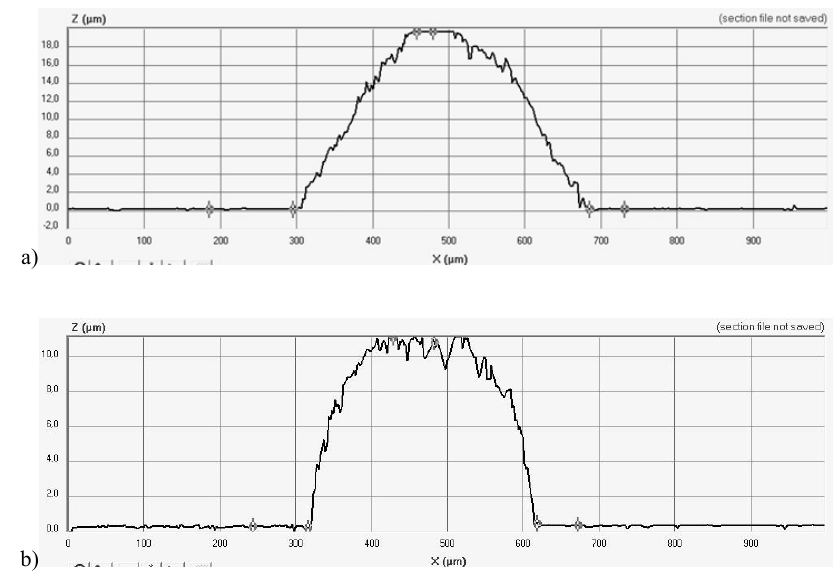
Fig. 6. Examples of profilograms of films after heat treatment: a) 180°С , b) 310°С .